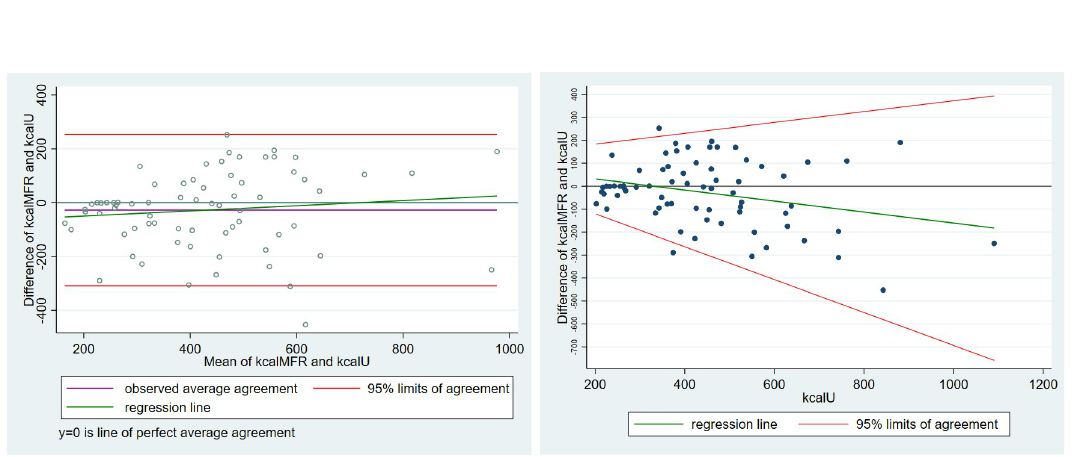
Fig 7. (Left) Classical Bland-Altman LoA plot augmented with the regression line, for high-caloric aliment cluster (right) Linear regression of the differences (y1—y2) on y2 with 95% limits of agreement.